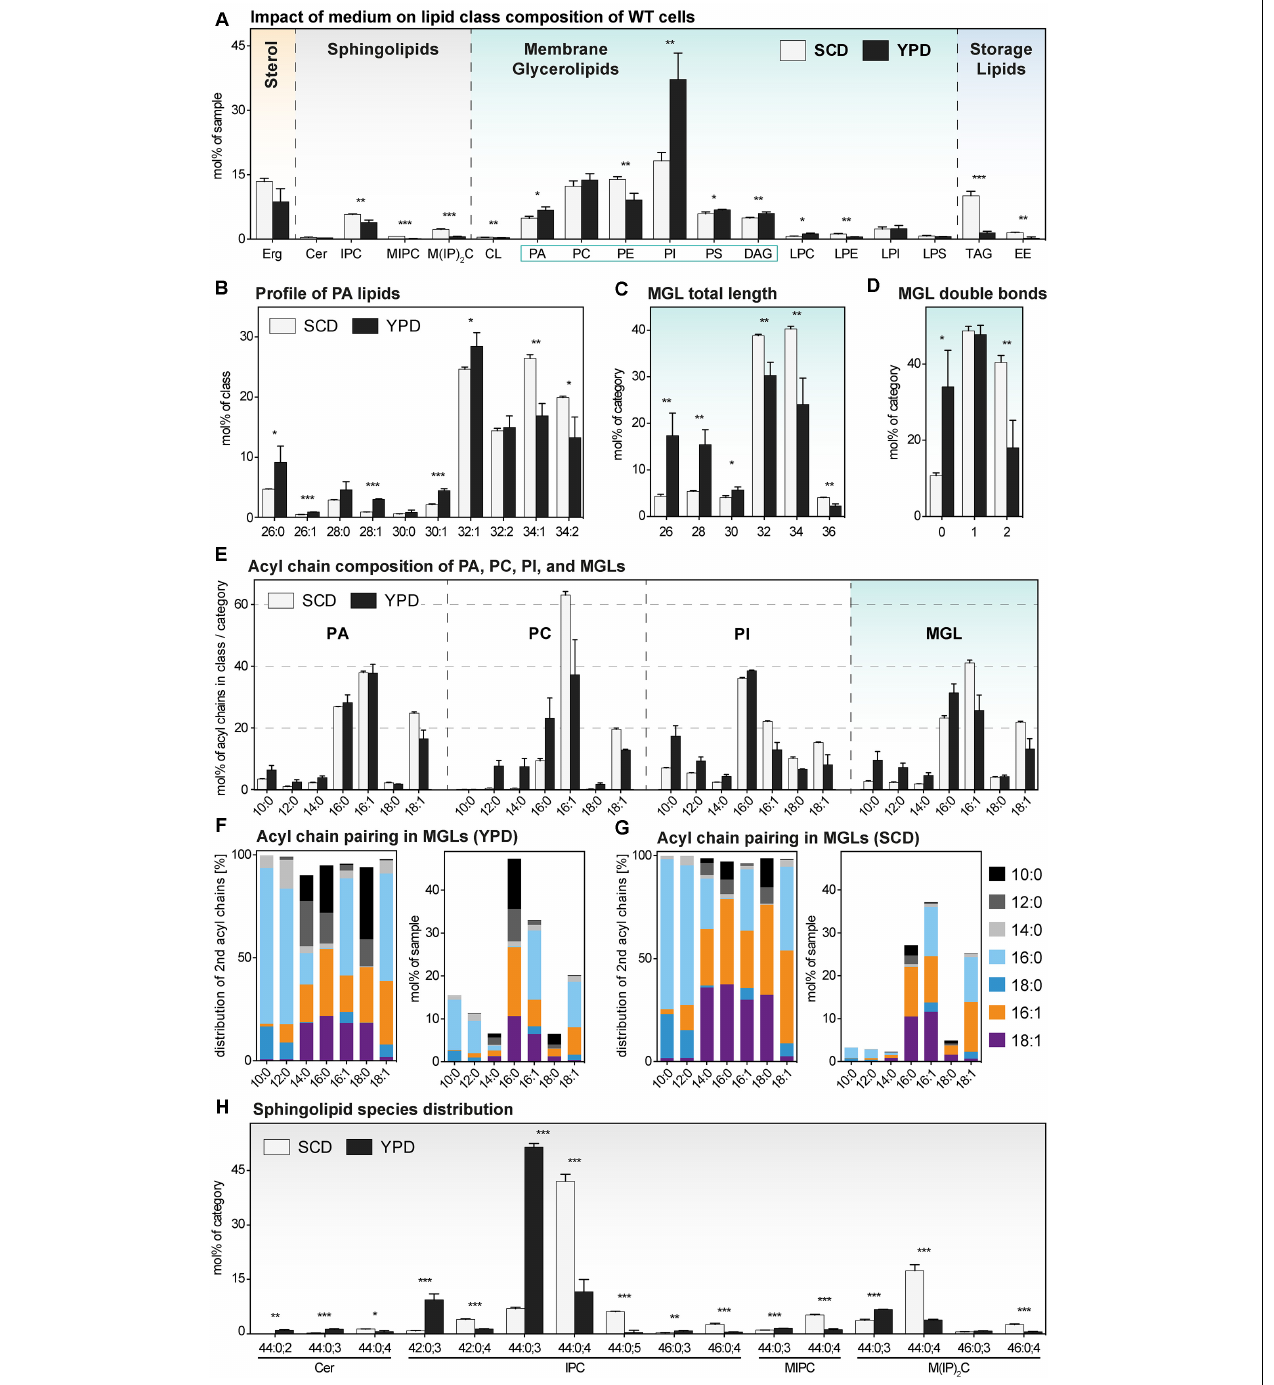
FIGURE 3 | The lipid composition of S. cerevisiae WT in different media. A single colony of the BY4741 WT strain was used to inoculate a preculture in either synthetic (SCD) or rich (YPD) medium. After overnight cultivation for 21 h, a fresh culture was inoculated to an OD 600 of 0.1. When the cells reached an OD 600 of 0.80 ± 0.05, they were cultivated for one more hour. 20 OD equivalents of these cells were harvested and analyzed by lipid mass spectrometry. The data represented by black and white bars relate to cells cultivated in rich and synthetic medium, respectively [except for panels (F and G)] . (A) Lipid class composition in mol% of all quantified lipids in the sample organized by the categories: sterol (orange), sphingolipids (magenta), membrane glycerolipids (green, classes with two acyl chains highlighted by green box), and storage lipids (blue). Erg, ergosterol; Cer, ceramide; IPC, inositolphosphorylceramide; MIPC, mannosy-IPC; M(IP)2C, mannosyl-di-IPC; CL, cardiolipin; PA, phosphatidic acid; PC, phosphatidylcholine; PE, phosphatidylethanolamine; PI, phosphatidylinositol; PS, phosphatidylserine;